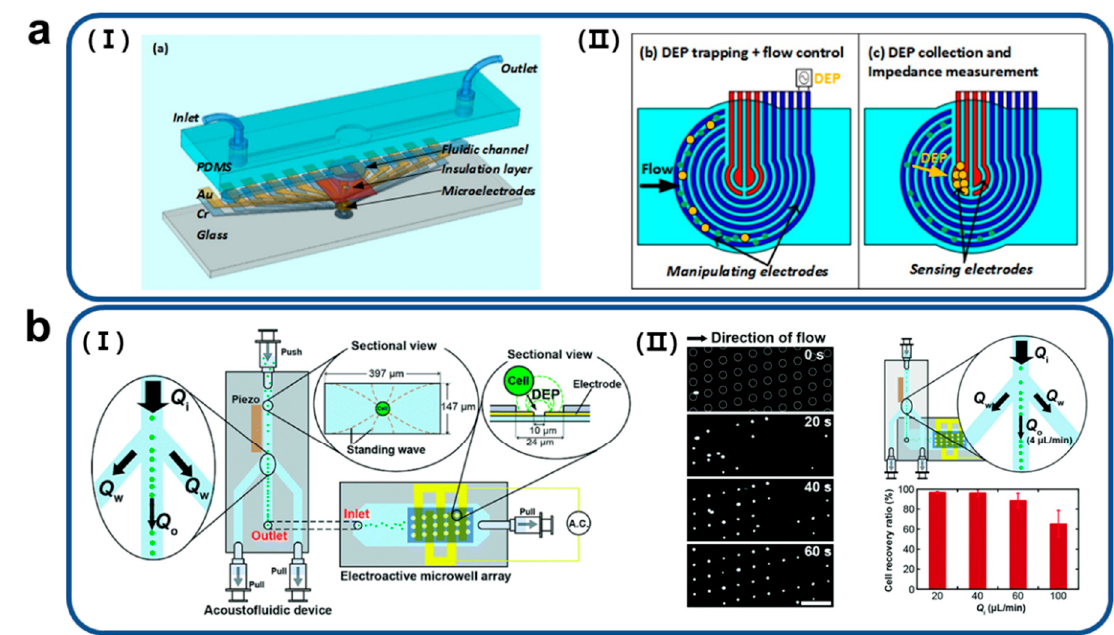
Figure 2. ( a ) Schematic diagram of (I) a microfluidic device combined with (II) circular microelectrodes capable of dielectrophoretic manipulation and electrical impedance measurement of target cells. Reproduced with permission from [40]. Copyright Lab on a Chip 2015. ( b ) (I) Schematic image of an acoustofluidic-based microfluidic device for high-throughput arrangement to the single-cell level. (II) Cells moving at a high-volume flow at the inlet of the microsystem were subsequently captured one by one in a microwell array through the dielectrophoresis principle. This device overcomes the bottleneck of cell analysis using a large sample volume. Reproduced from [41] with permission from the Royal Society of Chemistry.